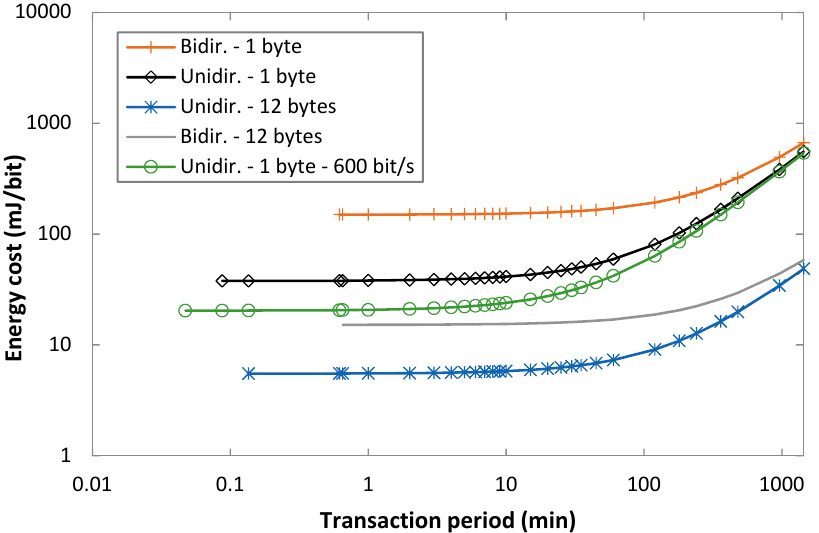
Figure 10. Energy cost of data delivery, for unidirectional and bidirectional transactions, as a function of T Period , and for uplink payload sizes of 1 byte and 12 bytes, for FLR = 0.